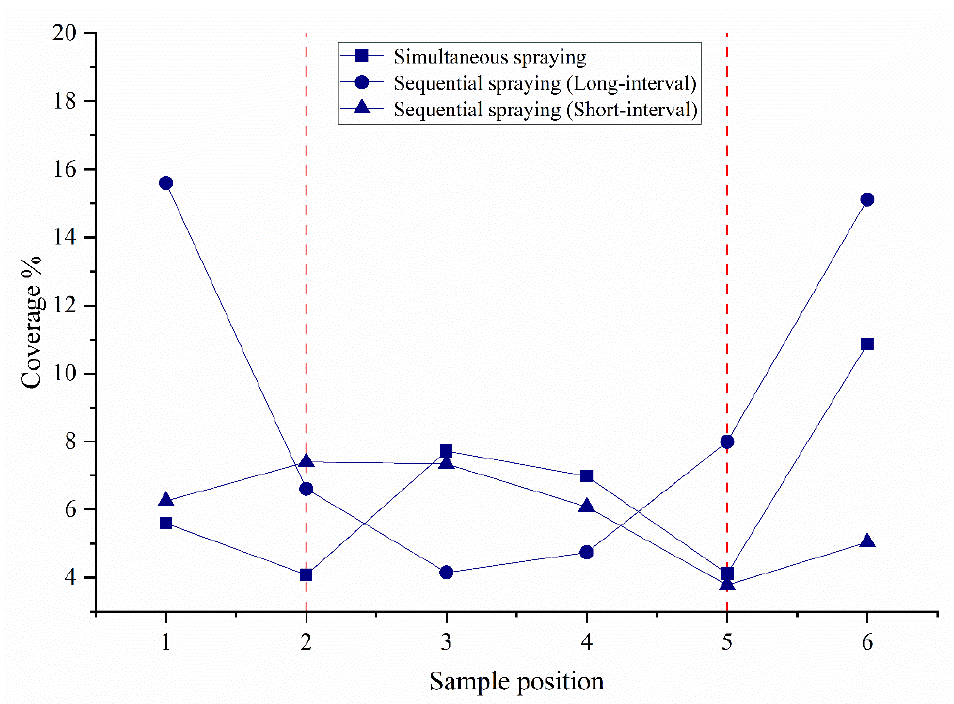
Figure 16. Spatial diagram of spray overlap area.